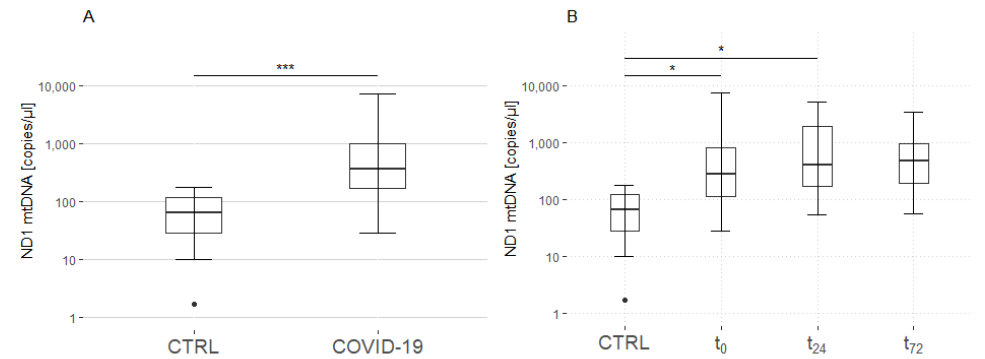
Figure 1. Quantification of ND1 mtDNA. ( A ): Significantly elevated levels of ND1 mtDNA were found in patients with COVID-19 compared with those in matched healthy controls. ( B ): Elevated levels of ND1 mtDNA were found in the COVID-19 patients after admission to the intensive care unit (t 0 ) and 24 h thereafter (t 24 ), compared with those in the controls. An analysis of the different time points among the COVID-19 patients revealed no significant differences. Asterisks display the degree of statistical significance: *: p ≤ 0.05, ***: p < 0.001. Abbreviations: COVID-19 = coronavirus disease; CTRL = control group; mtDNA = mitochondrial DNA; ND1 = NADH dehydrogenase 1.